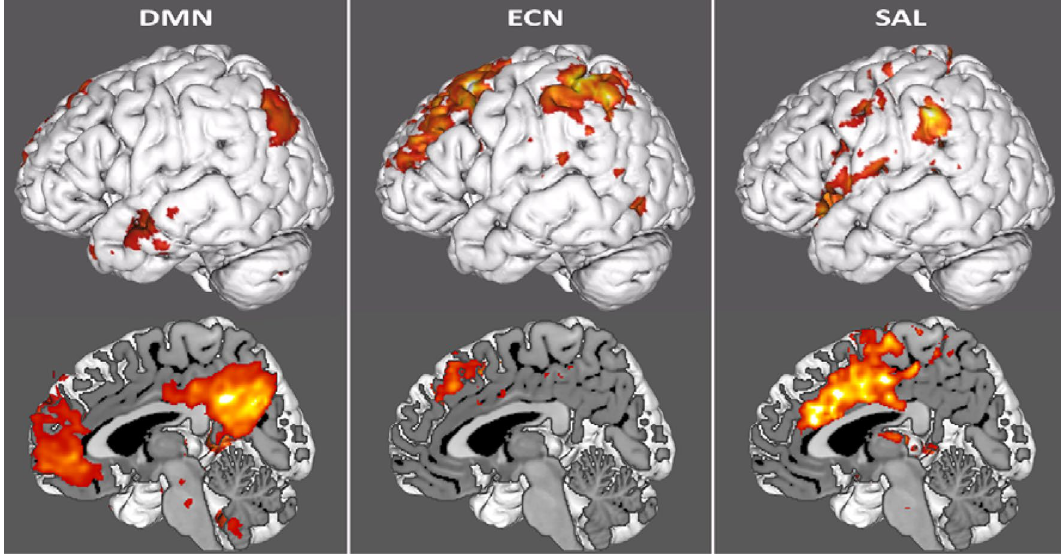
Figure 3. We display the group results for the three networks. Network connectivity is arbitrarily thresholded at z > 5 for display